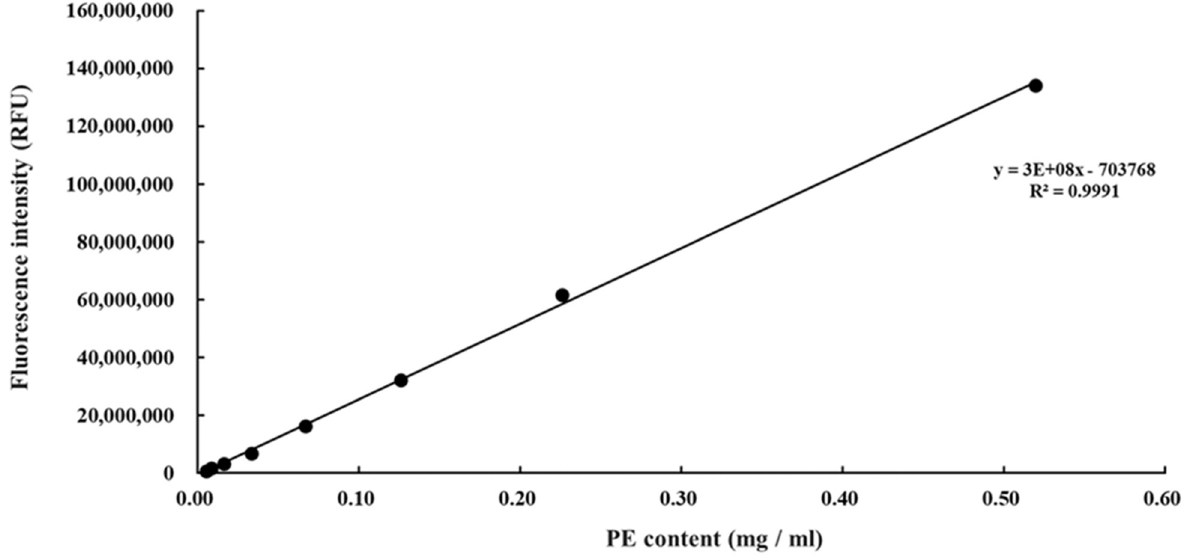
Figure 3. Detection of the fluorescence intensity and phycoerythrin (PE) concentration purified from Colaconema sp.